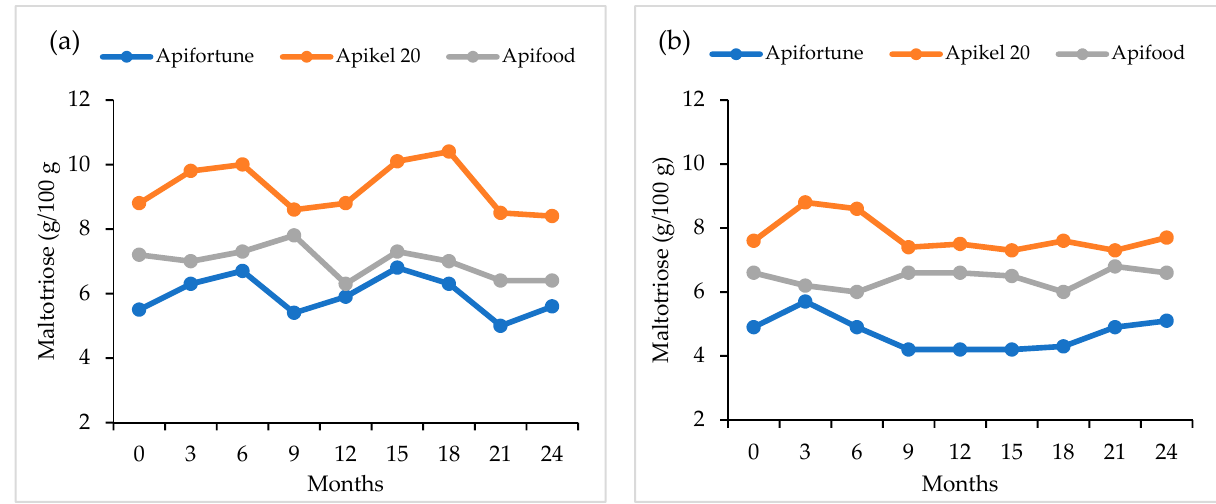
Figure 14. Changes of maltotriose content in syrups during storage at about 20 °C ( a ) from 2012 and ( b ) from 2013.